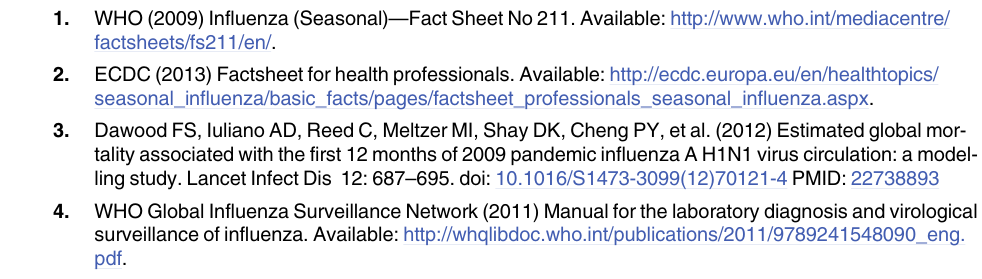
S3 Fig. Estimated ILI or ARI baseline for each study location. (TIF) S4 Fig. Meteorological smooth terms for specific humidity model (Model 1) with excess ILI or ARI as dependent variable. The y-axis is log(Y) and normalized. x-axis is the value of the meteorological variable. (TIF) S5 Fig. Estimated excess ILI or ARI in 2010/2011 season using specific humidity model (Model 1). Black line is the observations, red line is the predicted influenza, grey lines are the 95% CI. (TIF) S6 Fig. Meteorological smooth terms for minimum temperature model (Model 2) with excess ILI or ARI as dependent variable. The y-axis is log(Y) and normalized. x-axis is the value of the meteorological variable. (TIF) S7 Fig. Estimated excess ILI or ARI in 2010/2011 season using specific humidity model (Model 1). Black line is the observations, red line is the predicted influenza, and grey lines are the 95% CI. (TIF) S1 Table. Regression model for excess ILI or ARI (Model 1 with specific humidity) (DOCX) S2 Table. Regression model for excess ILI or ARI (Model 2 with minimum temperature) (DOCX) S1 Text. Details on analytic approach, meteorological data and supplementary results.